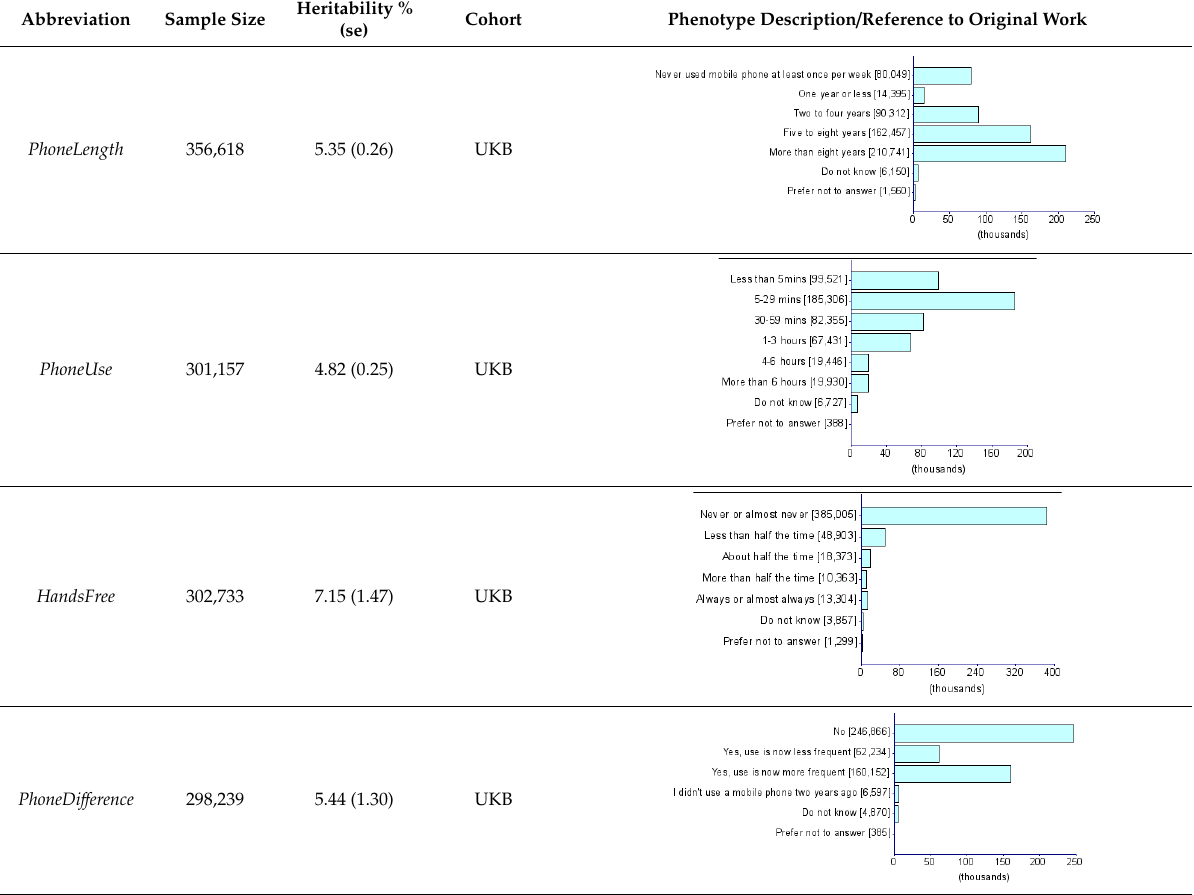
Table 1. General information for computerized device UK Biobank (UKB) traits and Psychiatric Genomes Consortium (PGC) disorders. Note that data distributions are based on the entire UKB.